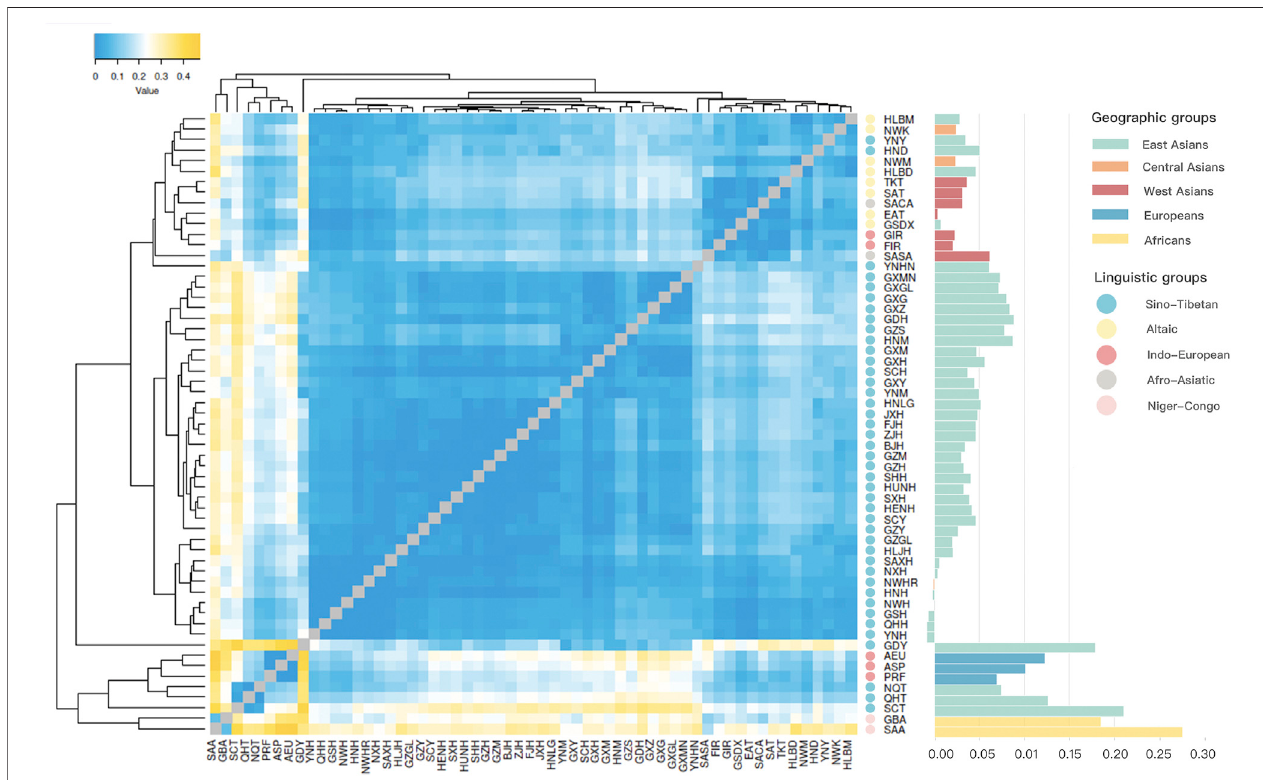
FIGURE 5 | A cluster heatmap constructed based on the pairwise R st values of the Northwest Hui group and 58 reference populations, in combination with a histogram of pairwise R st values between the Northwest Hui group and other reference populations in the right